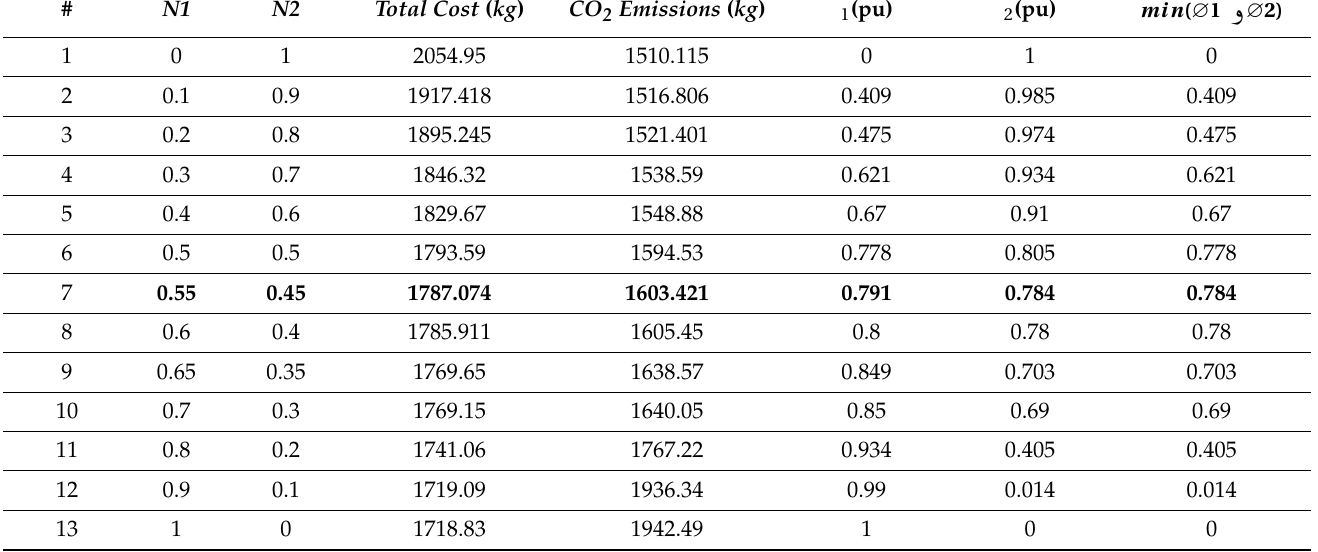
Table 5. Pareto optimal solutions for scenario 3.